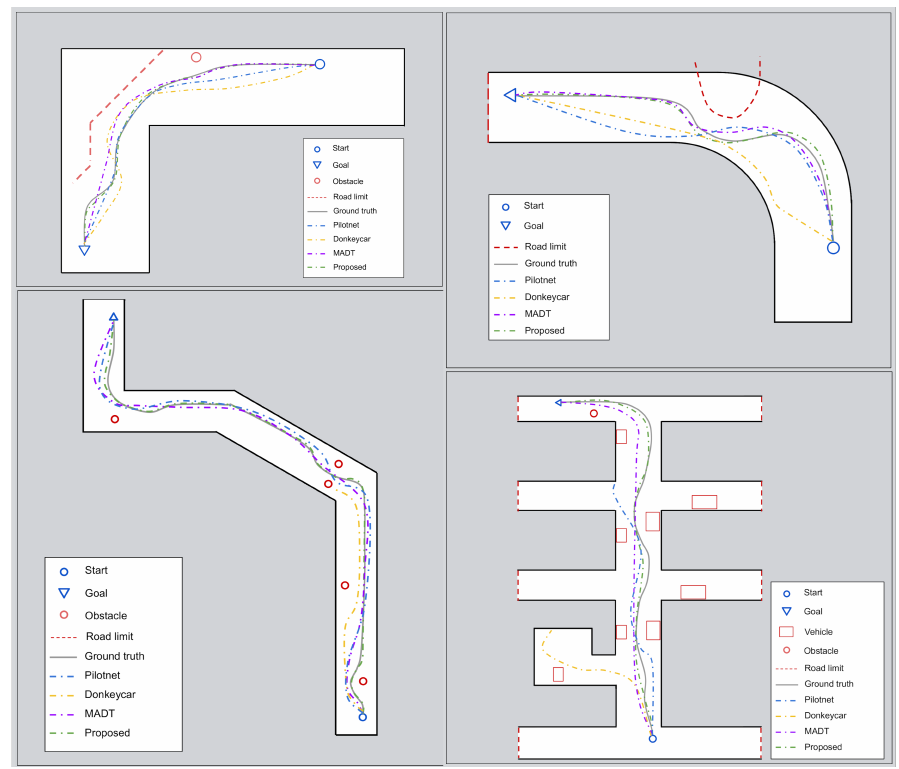
Figure 8. Trajectories obtained during self-driving in simulated environments.